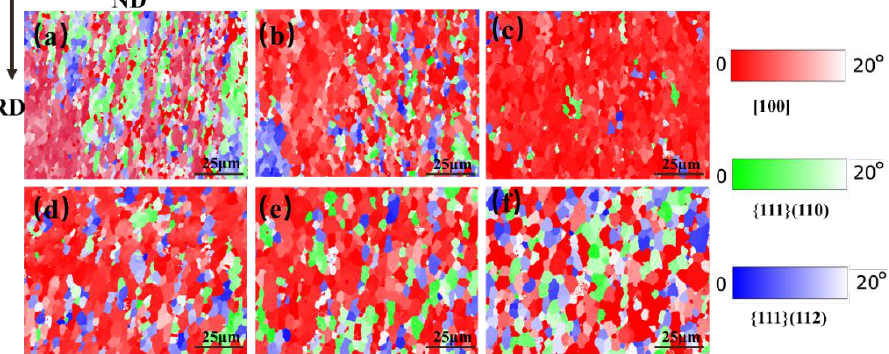
Figure 18. TC texture composition maps for Mo − 1.5wt% ZrO 2 molybdenum alloy at strain rate of